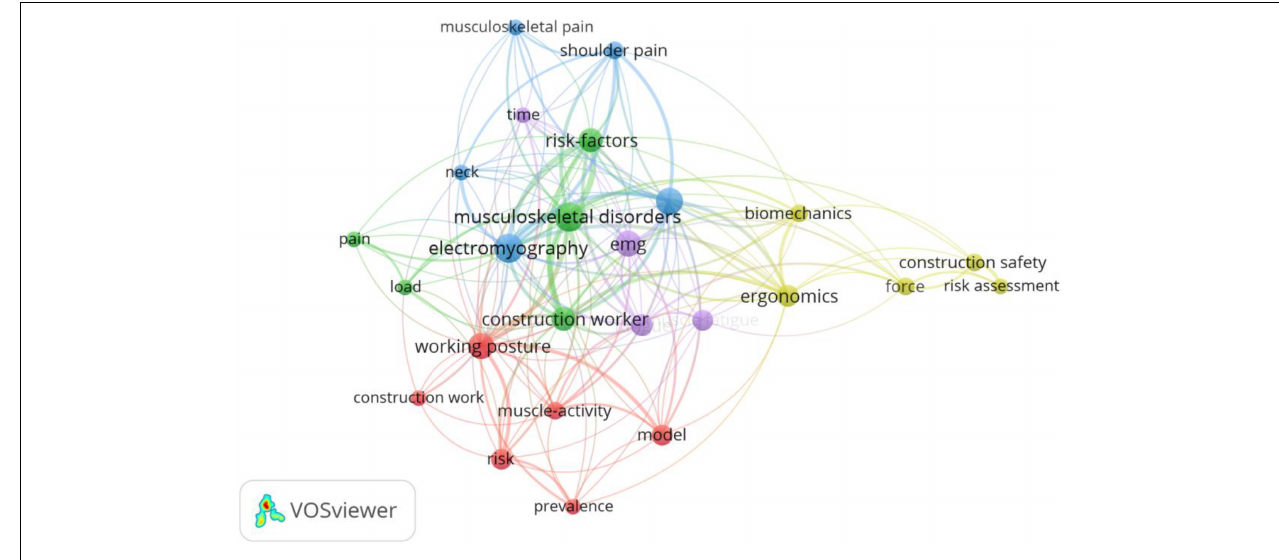
FIGURE 7 | Keywords co-occurrence network of EMG in building construction.